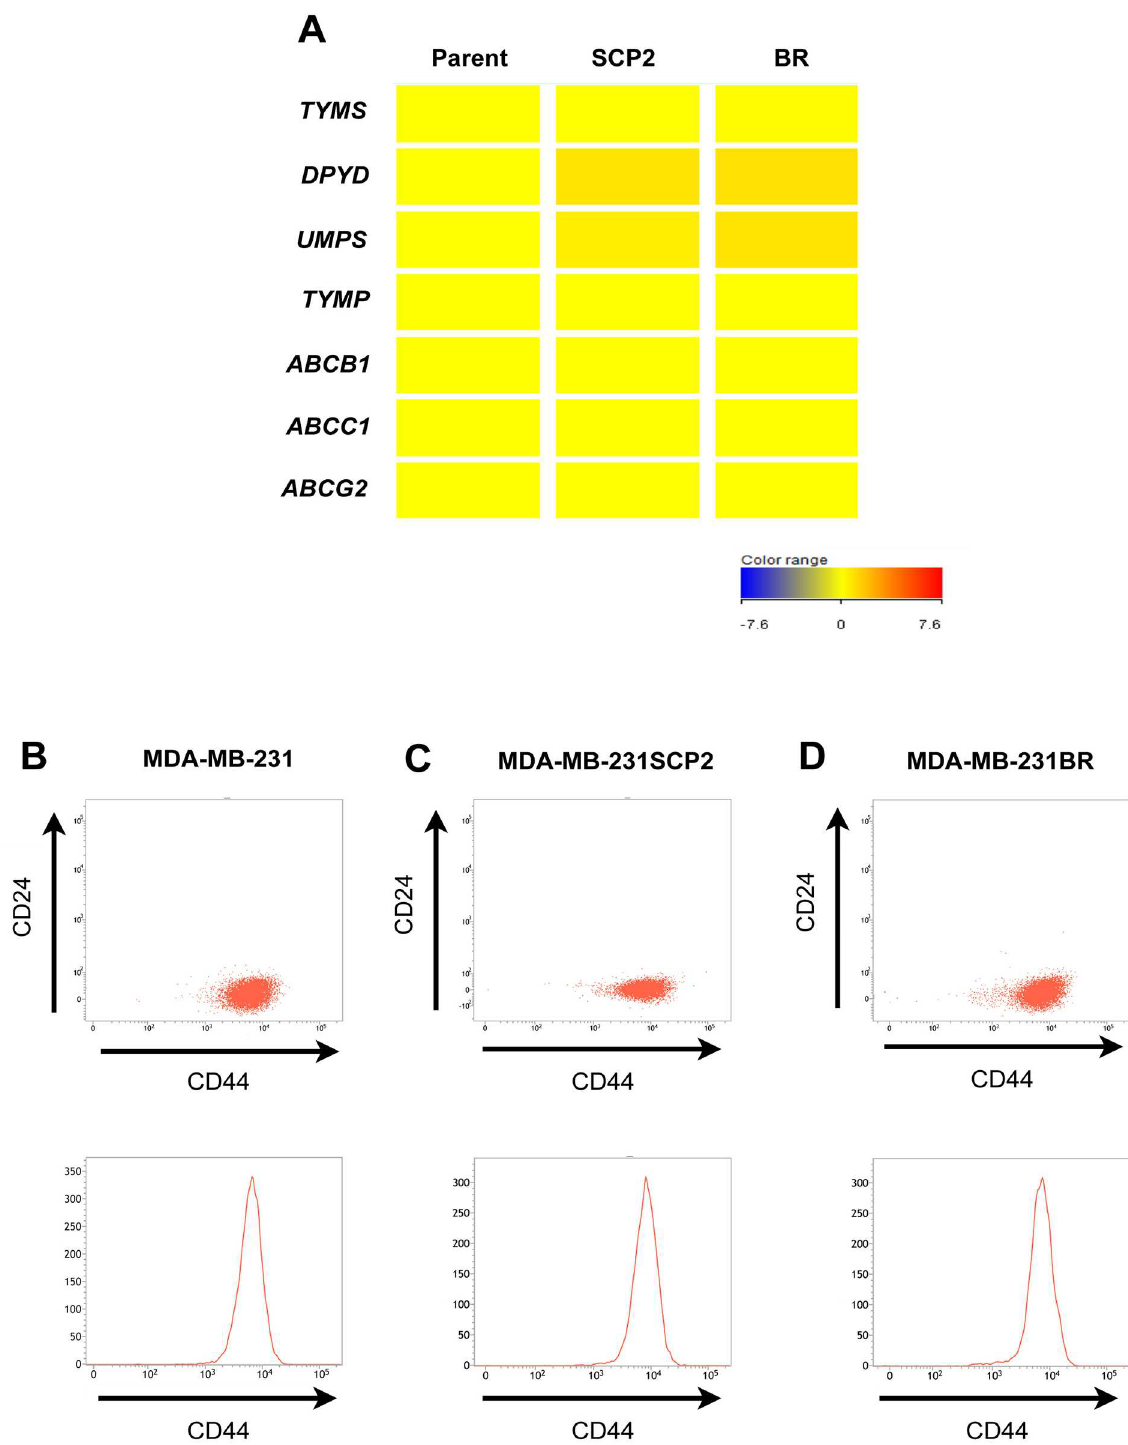
Fig 2. Gene expressions and breast cancer stemness in MDA-MB-231 and its metastatic variants. (A) Gene expression levels in MDA-MB-231 (Parent), MDA-MB-231SCP2 (SCP2), and MDA-MB-231BR (BR). Candidategenes for drug resistance were screened by RNA sequencing. The intensity of gene expression in the heat map is shown relative to that in the Parent. (B-D) Flow cytometry analysis of MDA-MB-231 and its metastatic variants. (B) MDA-MB-231. (C) MDA-MB-231SCP2. (D) MDA-MB- 231BR. Both scatter plots and histograms demonstrate that the CD44 + /CD24 - populationsof the two metastatic variants were not different from those of their parent cell line.